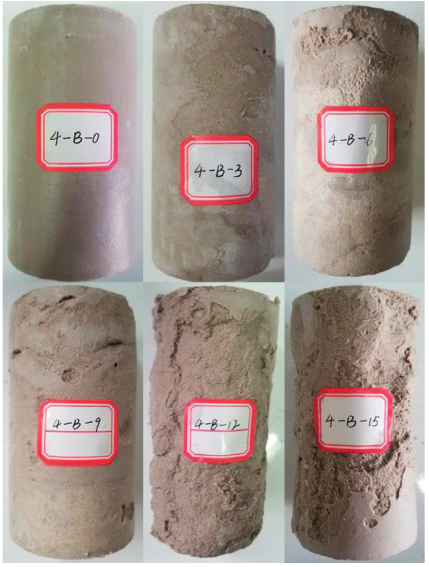
Figure 7: Saturated specimens under different dry-wet